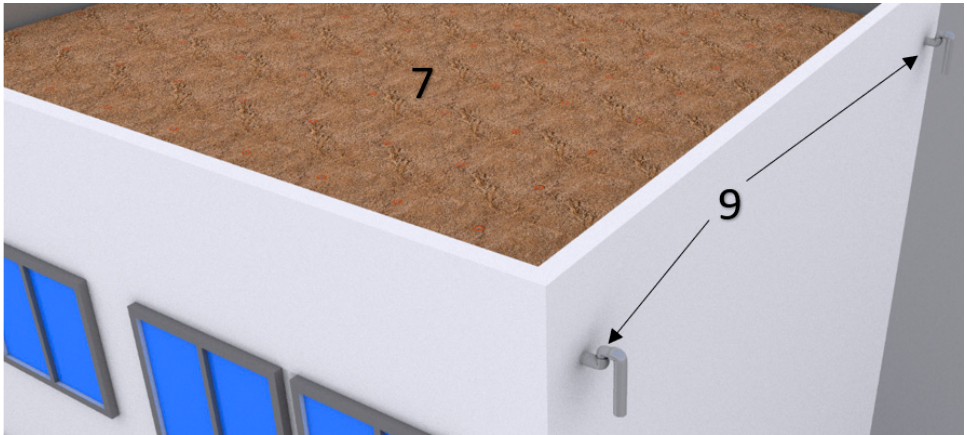
Figure 7. Soil media on the top of the root barrier layer (8 cm or more, depending on the plants). (7) soil media; (9) exit upside-down U-shaped tube.